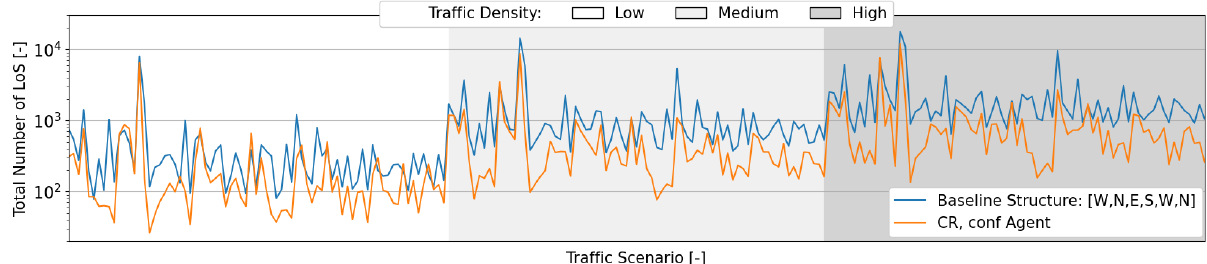
Figure 16. Mean total number of losses of separation. All traffic densities have 75 traffic scenarios, with the initial direction(s) and the number of turns following the same order as shown during the training phase.